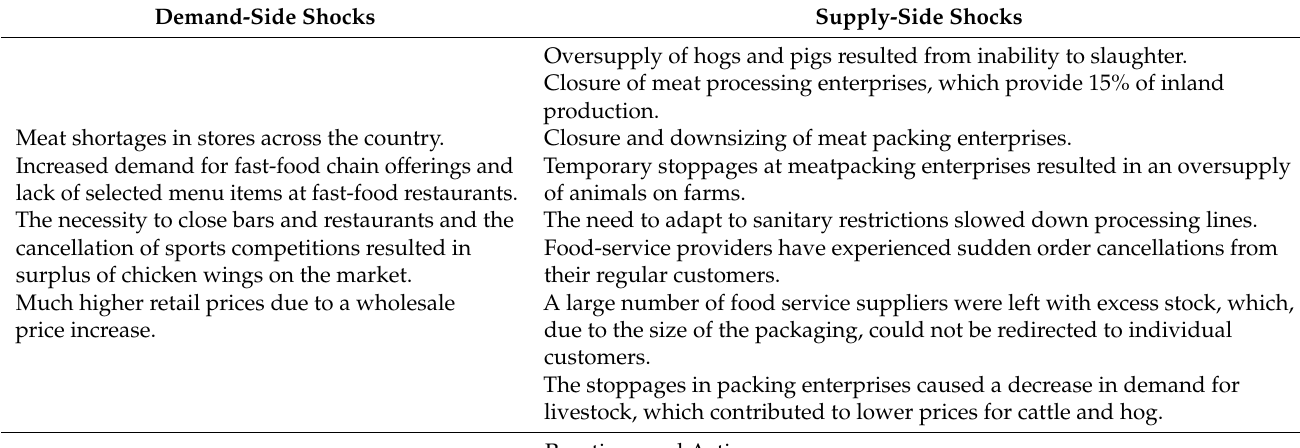
Table 5. The case of United States of America on the red meat market. Demand-Side Shocks Supply-Side